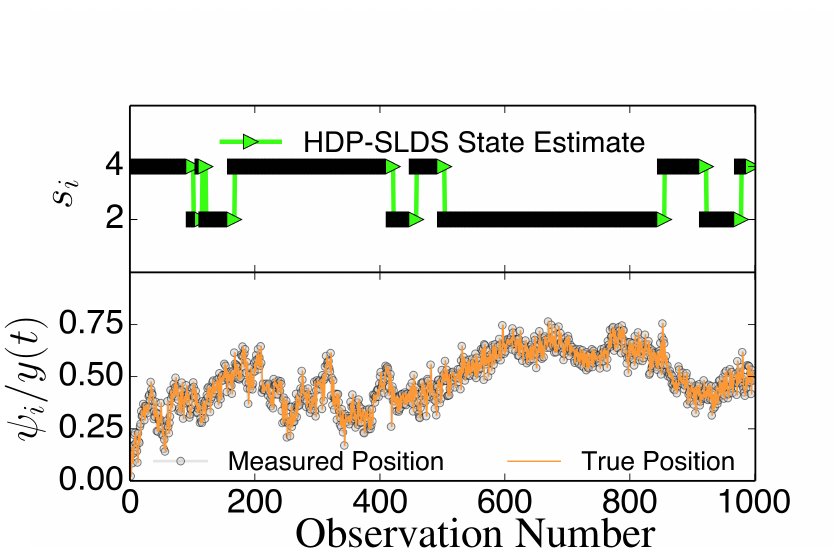
Figure 2. Illustration of abrupt changes in (cid:126)µ . The bottom panel displays the y component of the unobservable state (orange solid line) and the noisily measured values ψ (grey circles). y The top panel illustrates the inferred states s . In this trajectory, there are only two underlying i states that differ in their (cid:126)µ value; an abrupt change in (cid:126)µ induced by a state change causes y to slowly drift towards a fixed point dictated by the (unobserved) (cid:126)µ associated with the state (the magnitude of the drift or “mean reversion rate” depends on the distance of y from the fixed